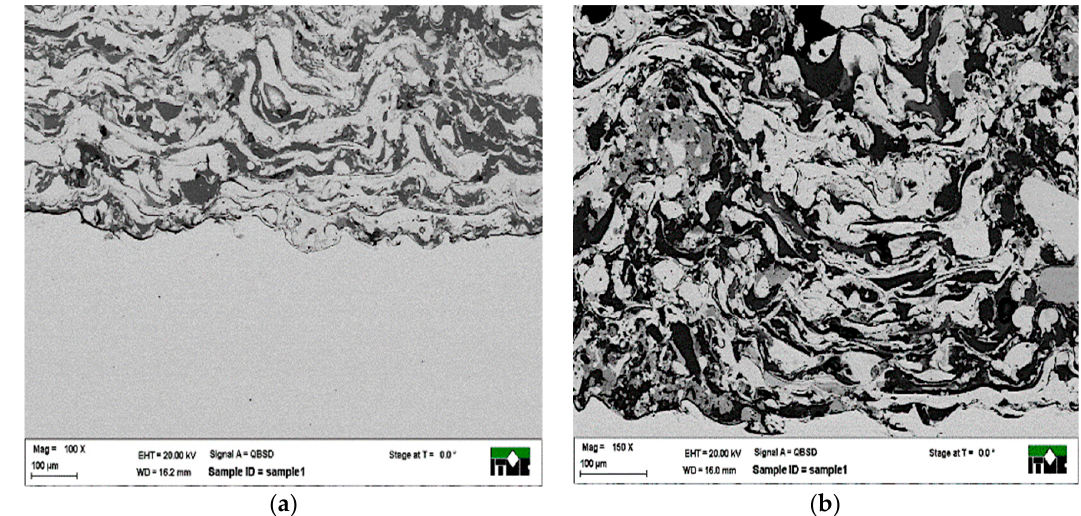
Figure 4. Scanning electron microscope (SEM) image of the microstructure of the arc sprayed Fe-Al coating on a steel substrate, ( a ) ×100, ( b ) ×150.